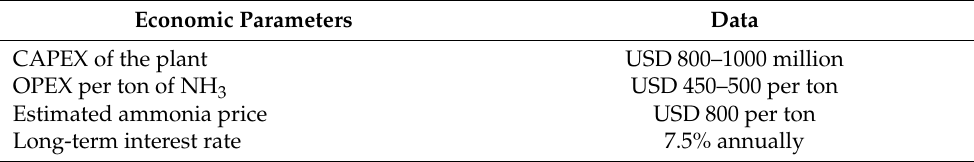
Table 2. Economic data block parameters.